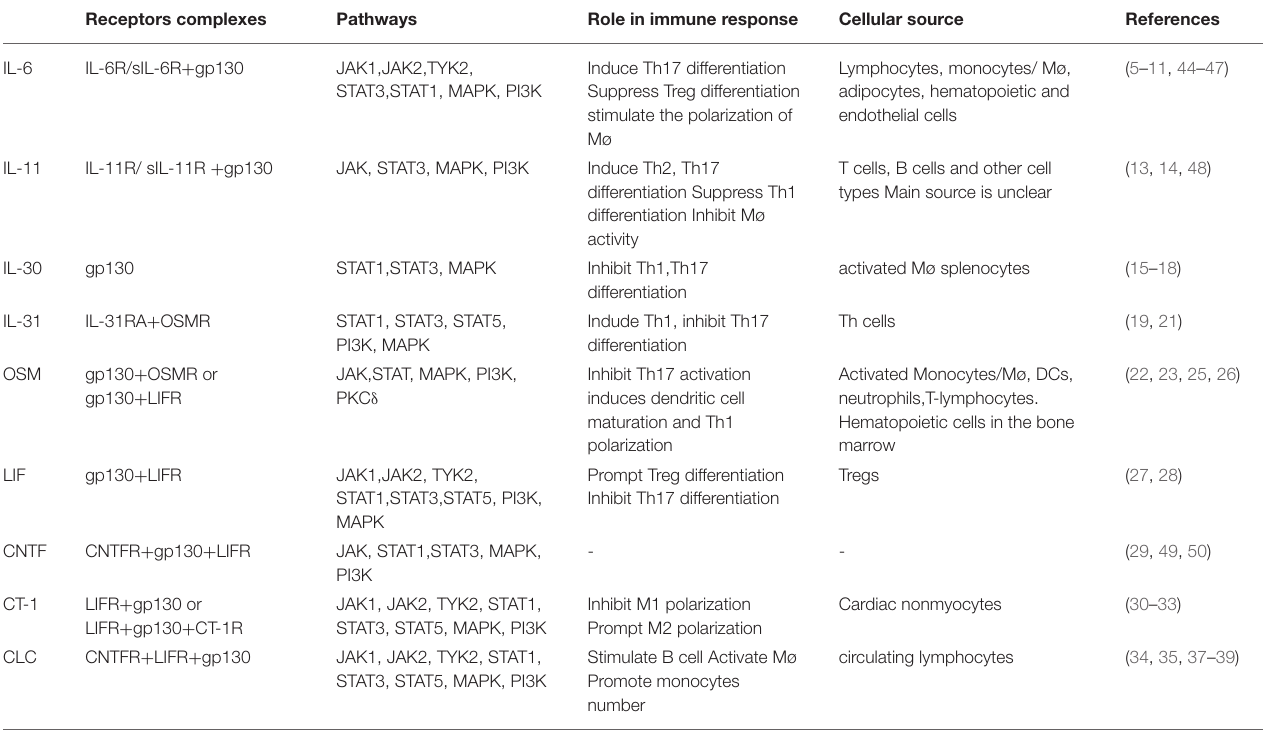
TABLE 1 | The receptor complexes and pathways of IL-6 family